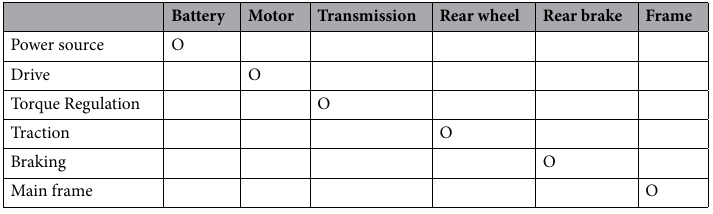
Table 16. Function-system allocation for the new product.